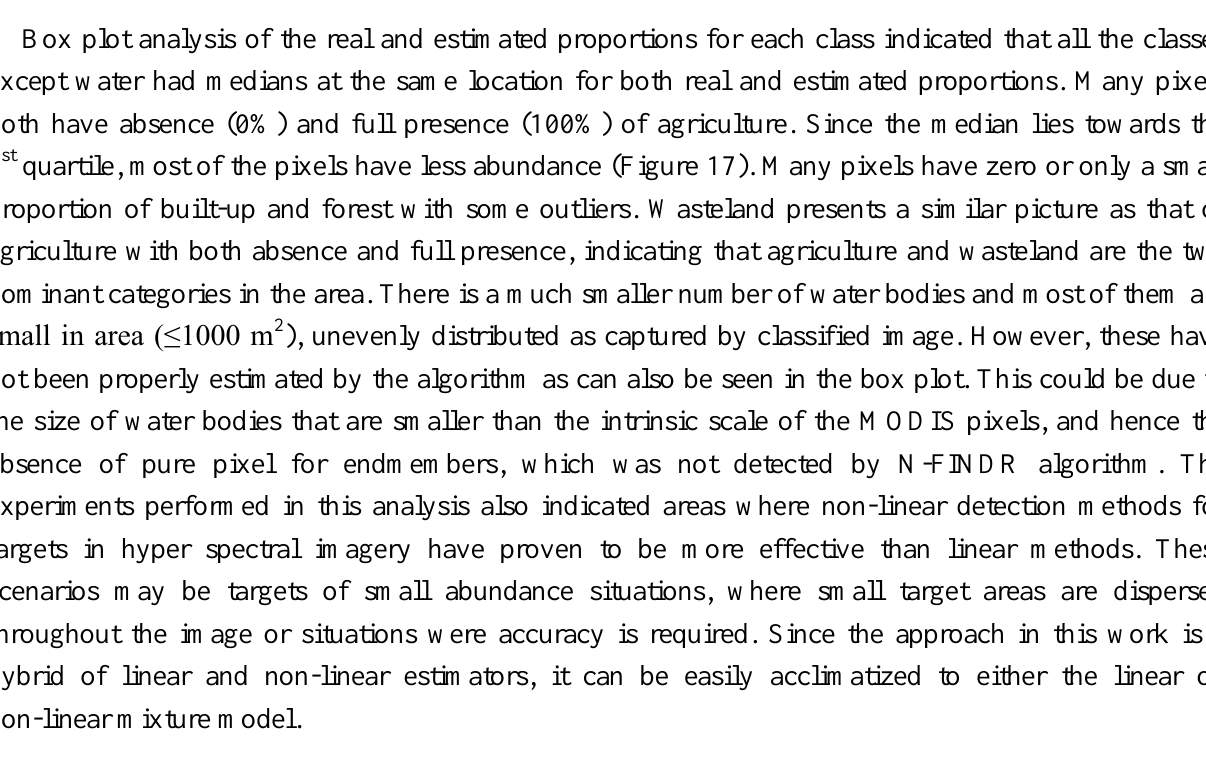
Figure 17. Box plot of the actual and estimated